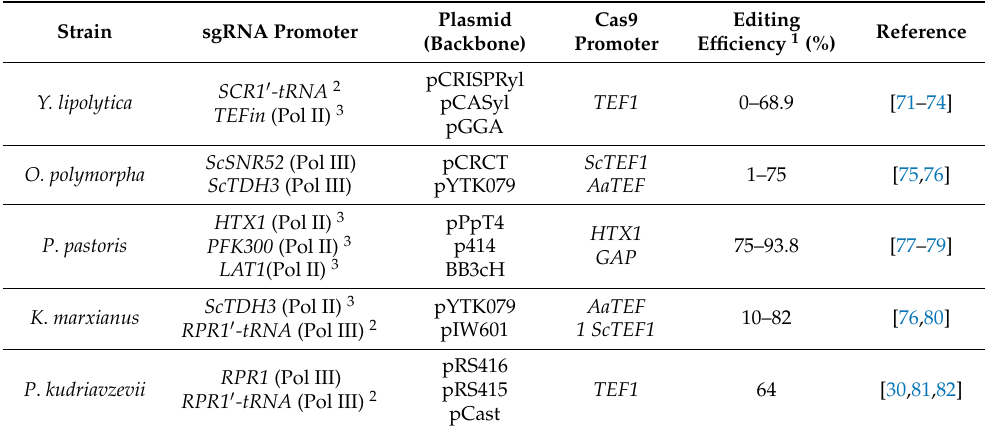
Table 1. Comparison of CRISPR-Cas9 system for